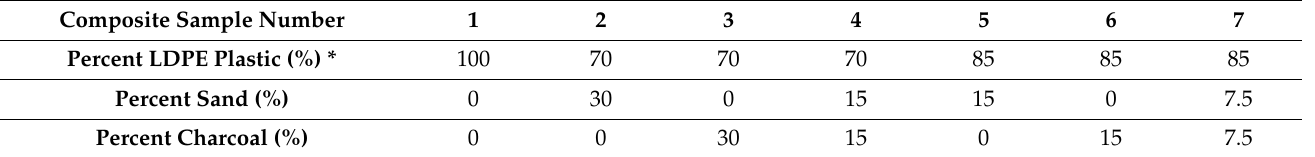
Table 1. Mixture composition (%) of the 7 samples produced and tested, each sample weighs 1 kg.